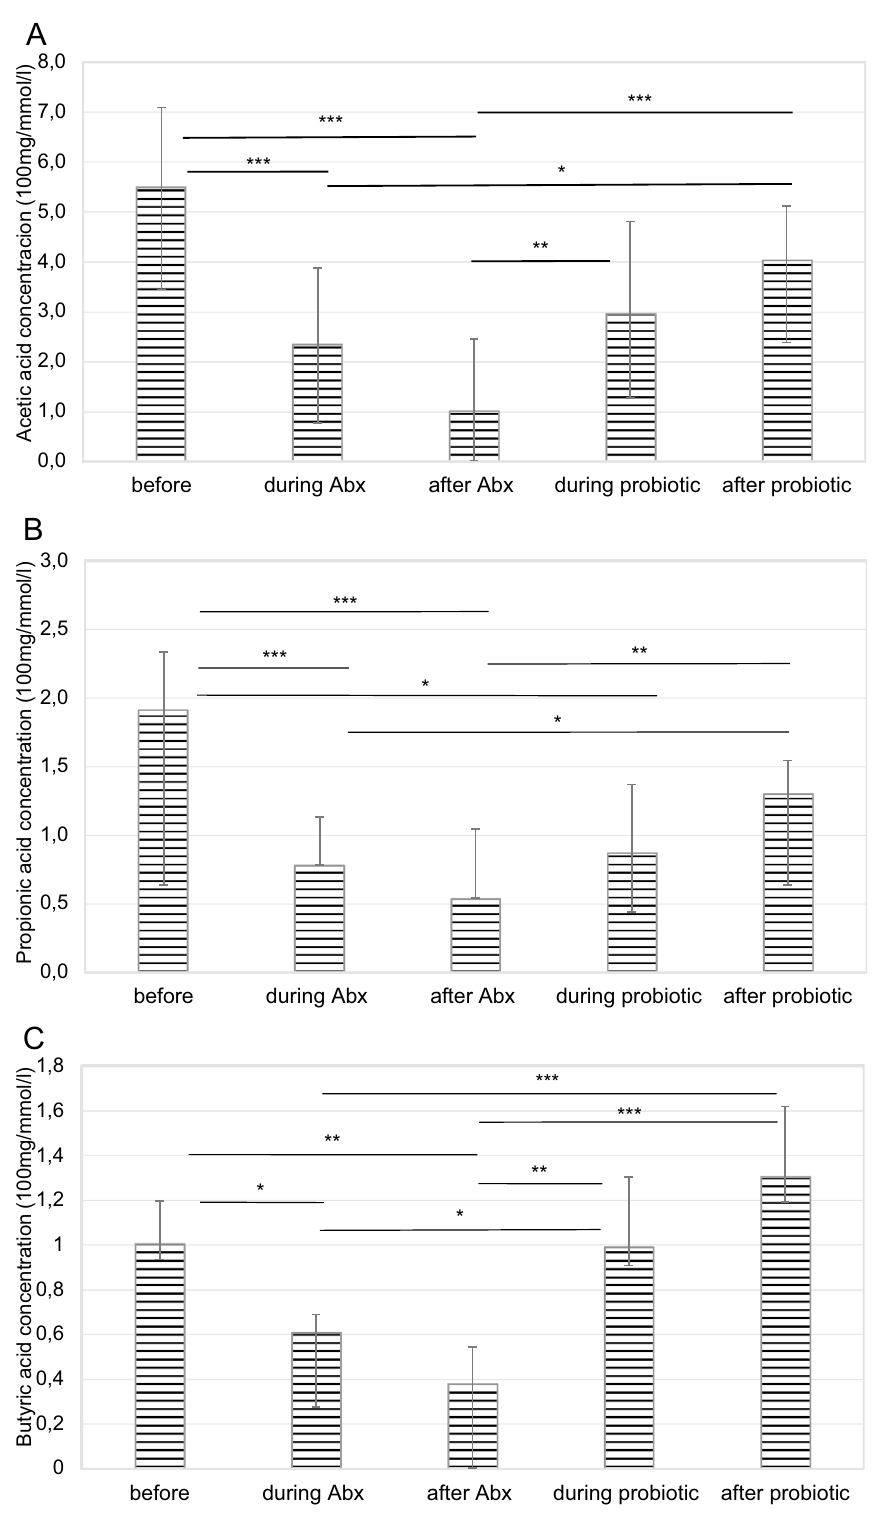
Figure 5. The effect of antibiotics and probiotic treatments on the acetic acid ( A ), propionic acid ( B ) and butyric acid ( C ) concentrations (100 mg/mmol/l) in the faecal samples before the treatments, during- and after the antibiotics treatment, as well as during- and after the probiotic treatment. Abx + probiotic: broad-spectrum antibiotics treated and after probiotic treated group; Friedman test (* p < 0.05; ** p < 0.01; *** p < 0.001). Data graphed as median ±